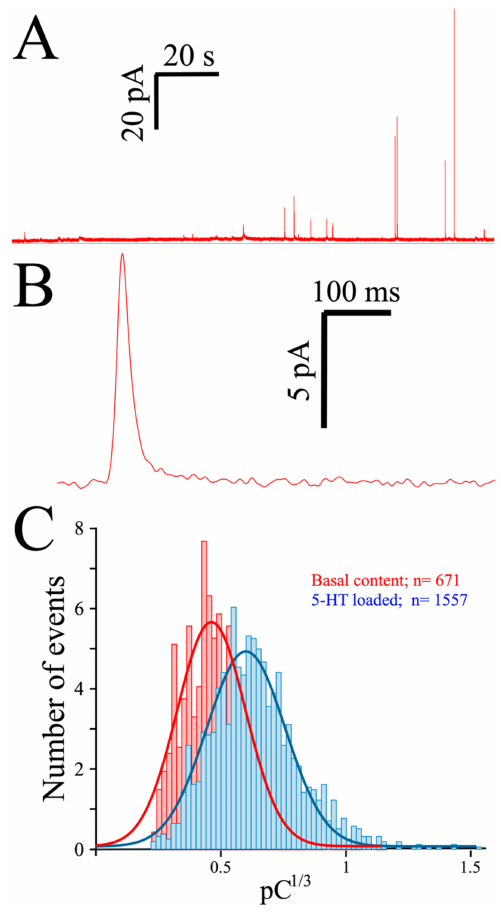
Figure 3. Exocytosis from human platelets measured with the MEA device . ( A ), Two-minute recording trace from a single MEA channel of platelets loaded for 2 h with 10 µ M serotonin (see Methods). ( B ), A single secretory spike resulting from an exocytotic event. ( C ), Spike charge histograms obtained from control and serotonin-loaded platelets. Superimposed lines show the distribution of the spike